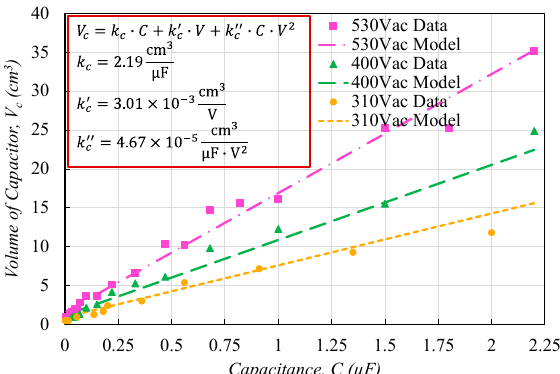
Figure 6. Proposed DM Capacitor Volume Model.